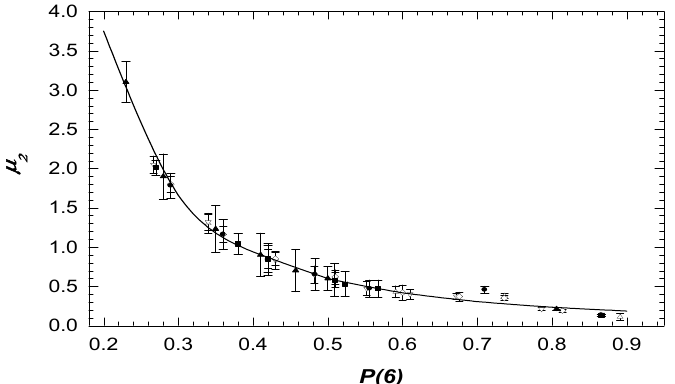
Figure 8. A plot of µ 2 against P (6) for the entire disordered wet foam of the cell. The line represents Equation (1).